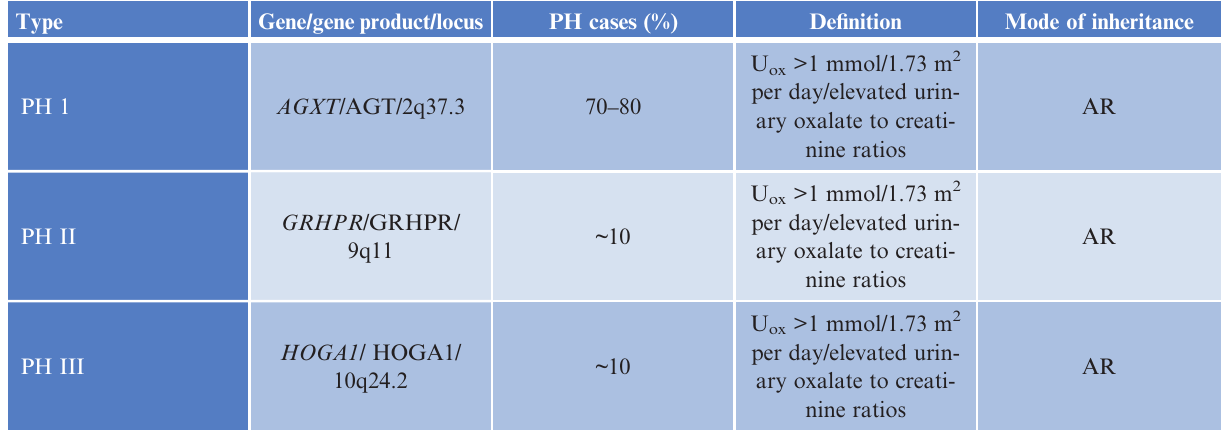
Table 3. Different types of primary hyperoxaluria Type